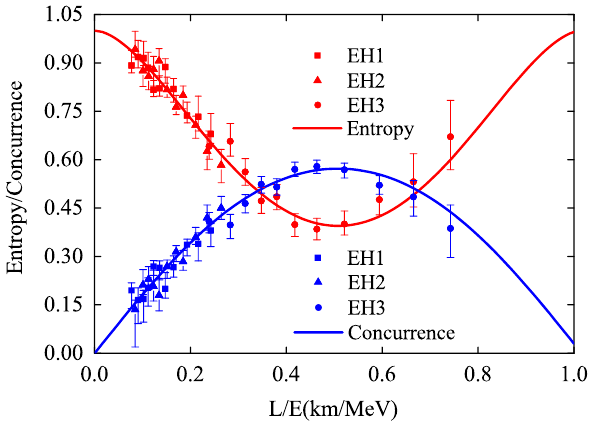
Fig. 6 Experimental results for the entanglement witness with respect to the ratio L / E for the initial electron flavor state. The entropy (solid line, red) S ( P | B ) + S ( R | B ) + log 2 c ( P , R ) , the concurrence (solid line, blue) of neutrino-flavor state in theory and experiment with the error